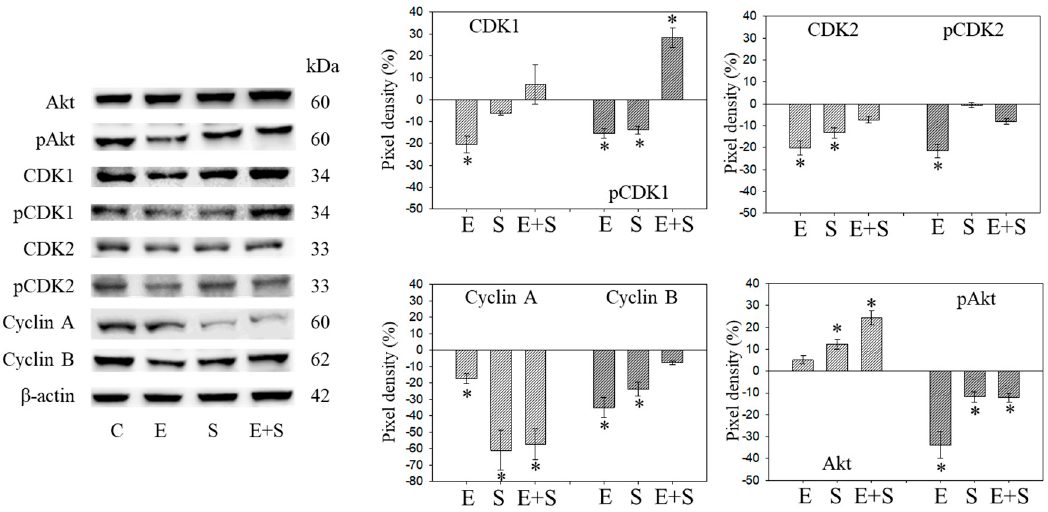
Figure 4. Protein profile of cell cycle regulating proteins (Akt, CDKs, Cyclins) after short-term exposure to 0.5 nM everolimus (E) or 2.5 µM sulforaphane (S) or 0.5 nM everolimus + 2.5 µM